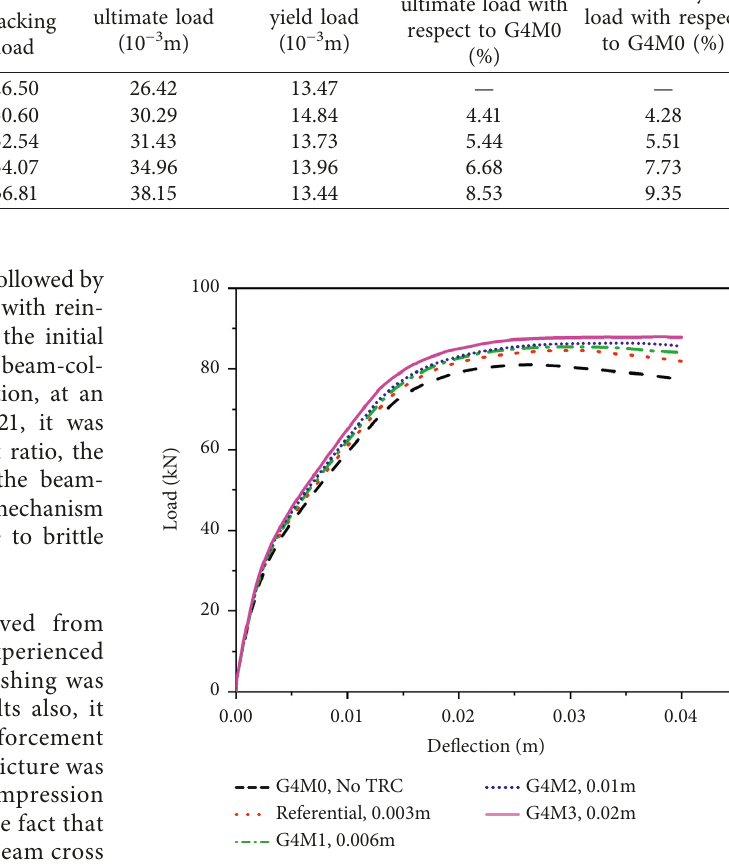
Figure 23: Load-deflection response of specimens with different thicknesses of TRC.